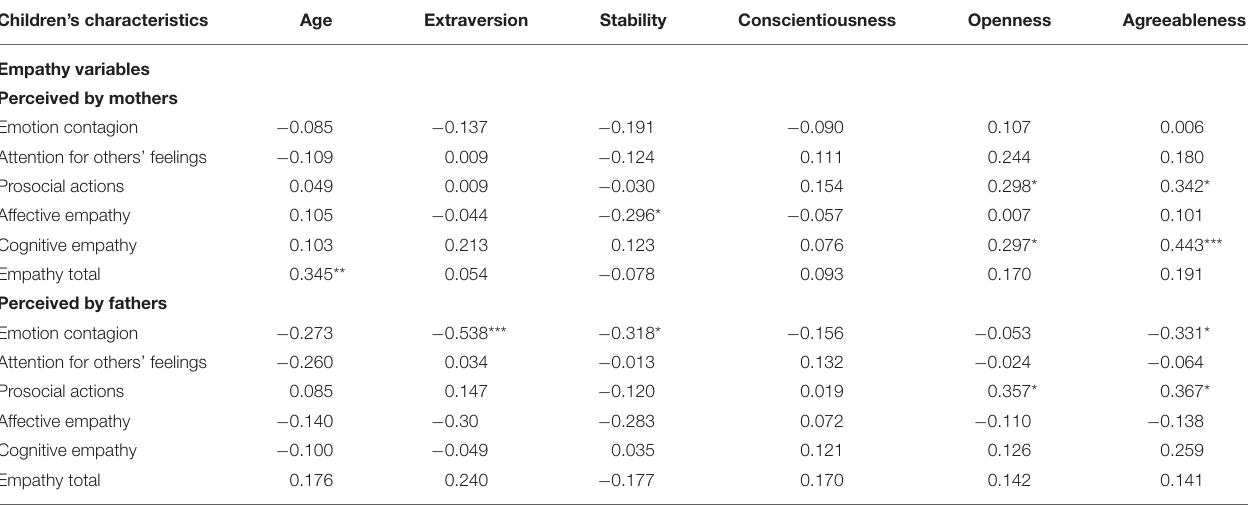
TABLE 3 | Spearman correlations between children’s individual characteristics and skills in empathy rating by mothers and fathers. Children’s characteristics